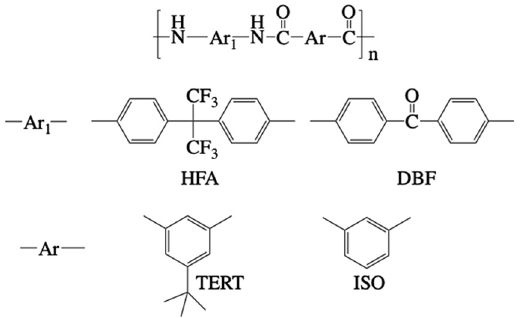
Figure 7: Structure of the PA having di ff erent bulky pendant groups ( 65,66 ) .